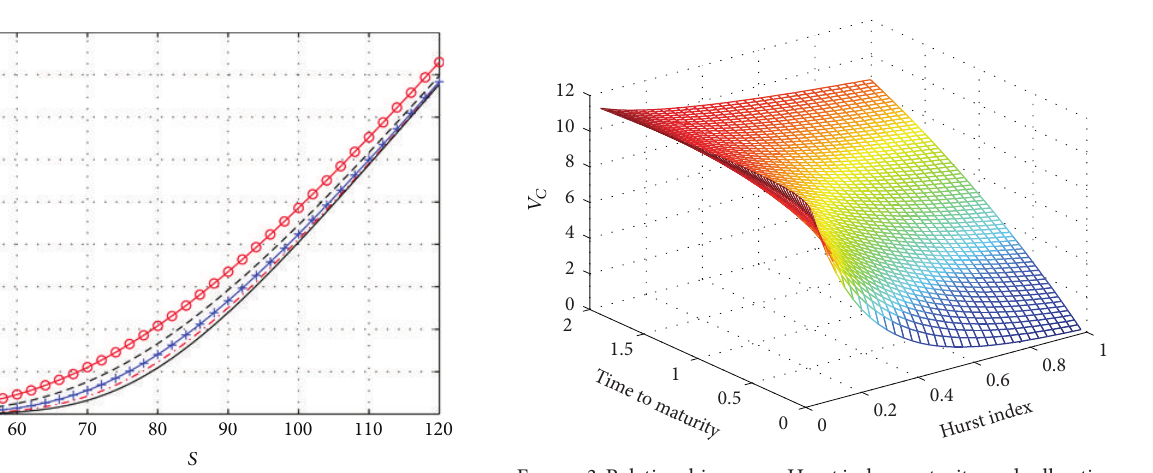
Figure3:RelationshipamongHurstindex,maturity,andcalloption value.